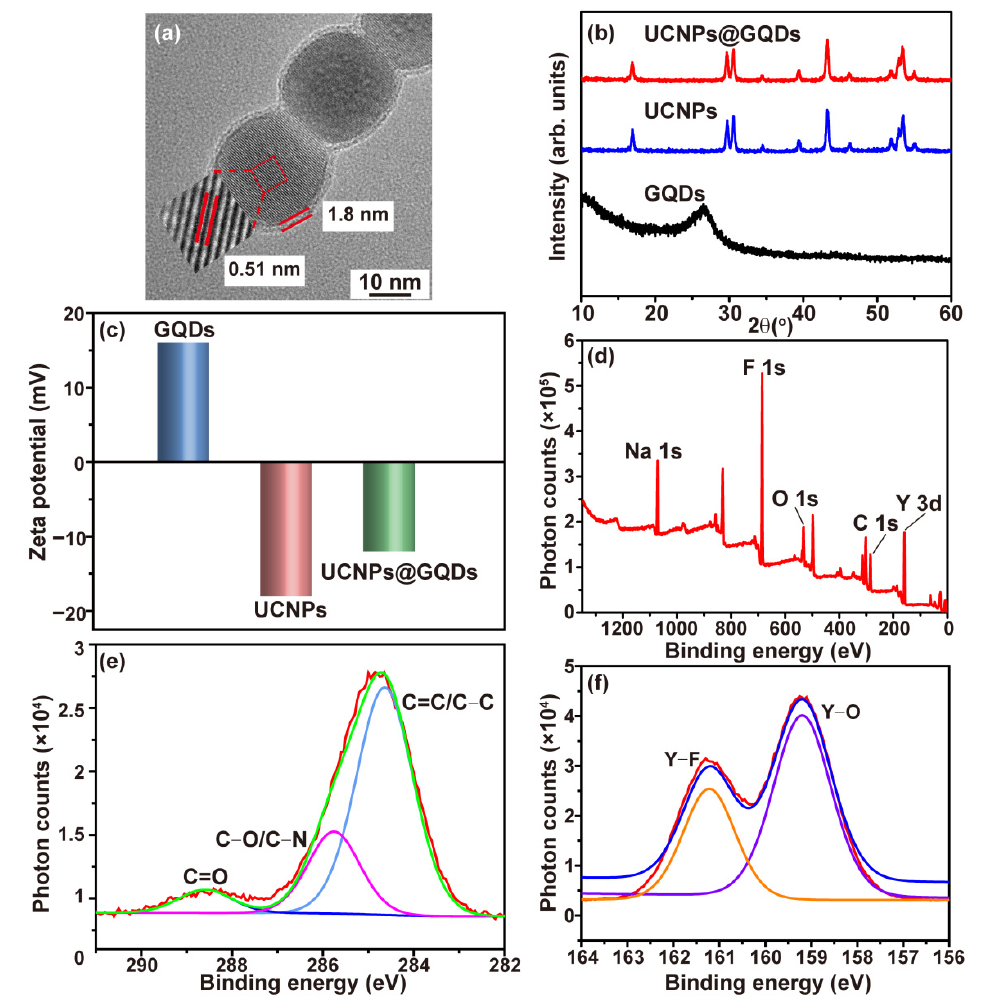
Figure 1. Characterization of UCNPs@GQDs. ( a ) HRTEM image of UCNPs@GQDs. The inset was the lattice fringes of UCNPs. ( b ) XRD pattern of UCNPs@GQDs. ( c ) Zeta potential of GQDs, UCNPs, and UCNPs@GQDs. ( d ) XPS survey spectrum of UCNPs@GQDs. ( e ) High-resolution C 1s XPS profiles of UCNPs@GQDs. ( f ) High-resolution Y 3d XPS profiles of UCNPs@GQDs.